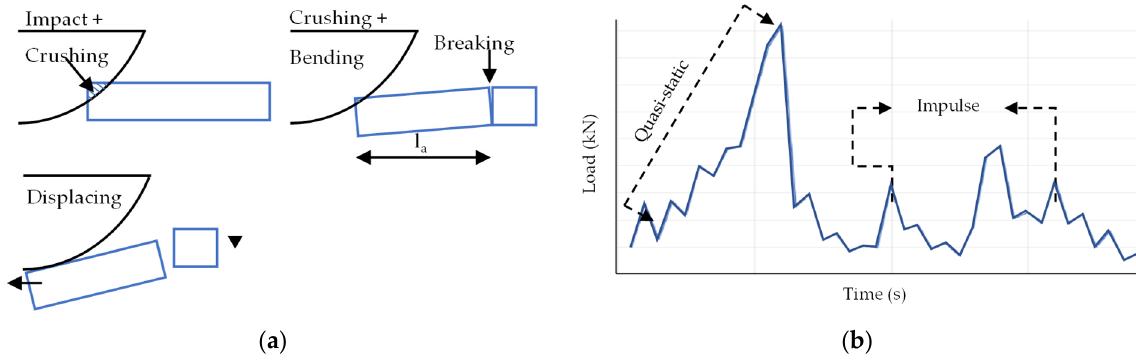
Figure 1. ( a ) Hull–ice interaction mechanism and ( b ) Within the associated ice loading pattern, flexural bending is assumed to be quasi-static while spalling, fracturing and material extrusion loads are assumed to be dynamic.